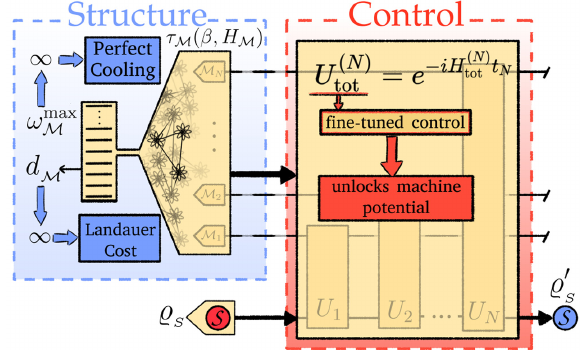
FIG. 2. Complexity. We consider structural (left) and control complexity (right). Structural complexity concerns properties of the machine Hamiltonian. For perfect cooling it is necessary that the largest energy gap diverges [see Eq. (5)]. Moreover, an infinite-dimensional machine with particular energy-level struc- ture is required for saturation of the Landauer bound. Control complexity refers to properties of the unitary that represents a protocol. The yellow box in the foreground represents a uni- tary U involving the entire machine, whereas the smaller yellow columns in the background represent a potential decomposition (e.g., of the diverging-time protocol) into unitaries U i involv- ing certain subspaces of the overall machine. Not only must the target system interact with all levels of an infinite-dimensional machine for Landauer-cost cooling, it must do so in a fine-tuned